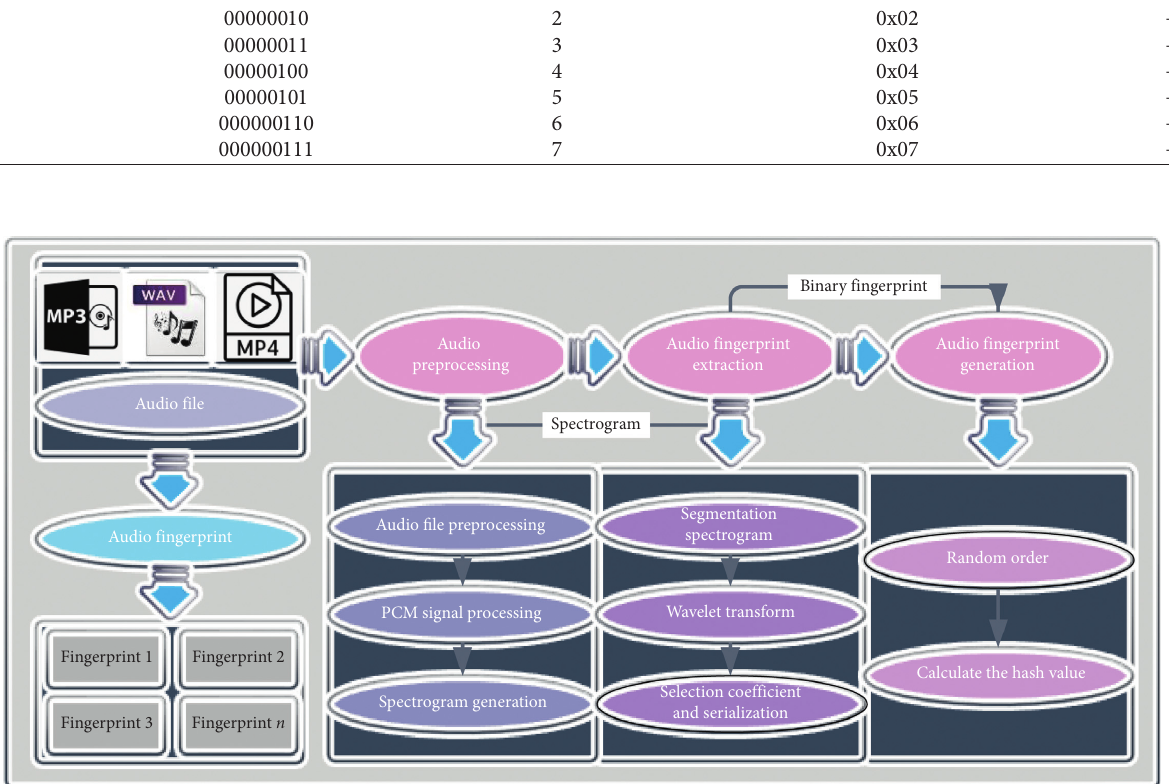
Figure 1: Flowchart of audio fingerprint extraction